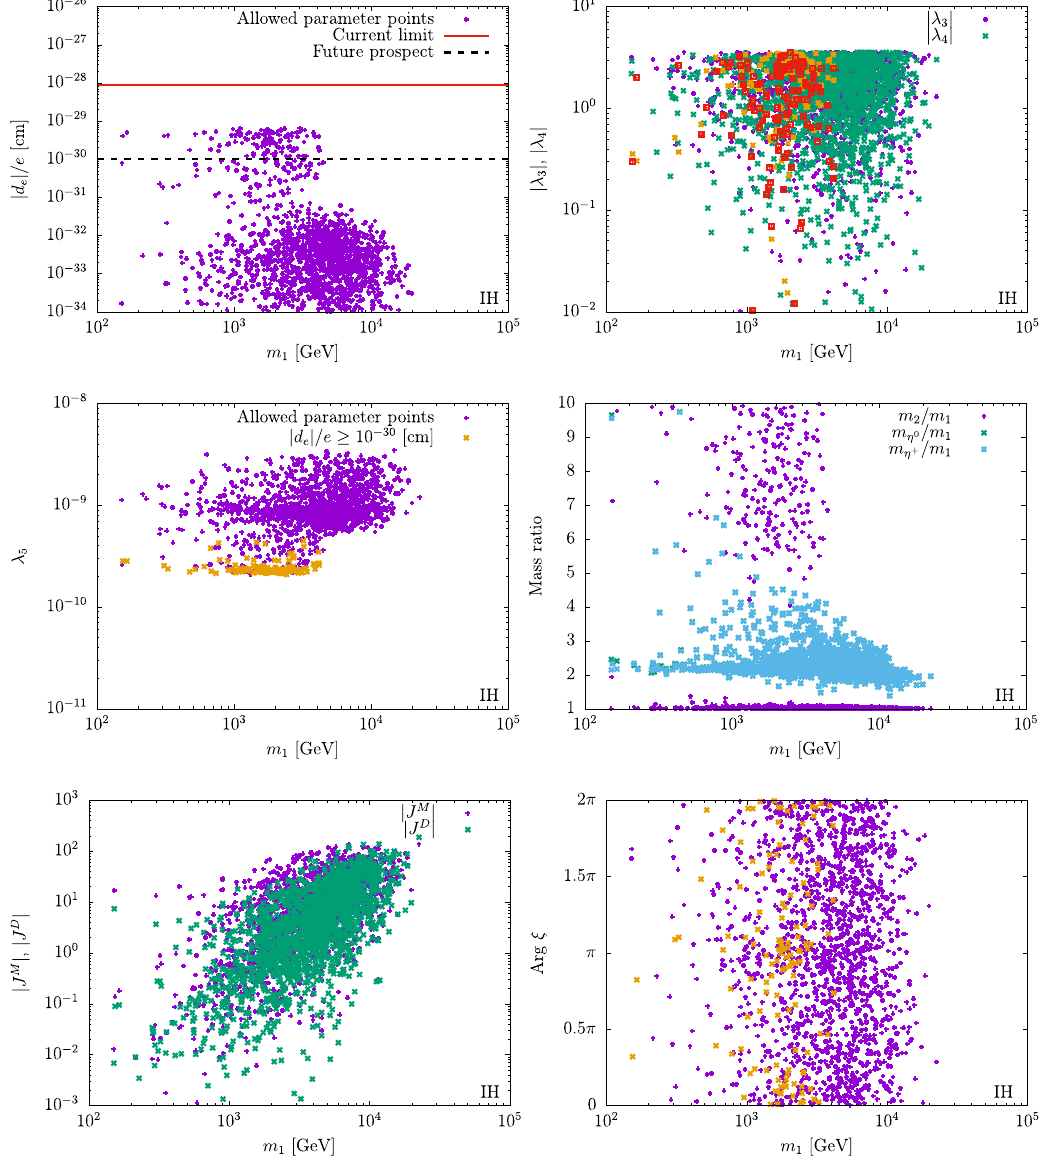
Figure 5 . Numerical results for fermion dark matter in the case of inverted hierarchy for the light neutrino spectrum. Each point complies with all the constraints discussed in section